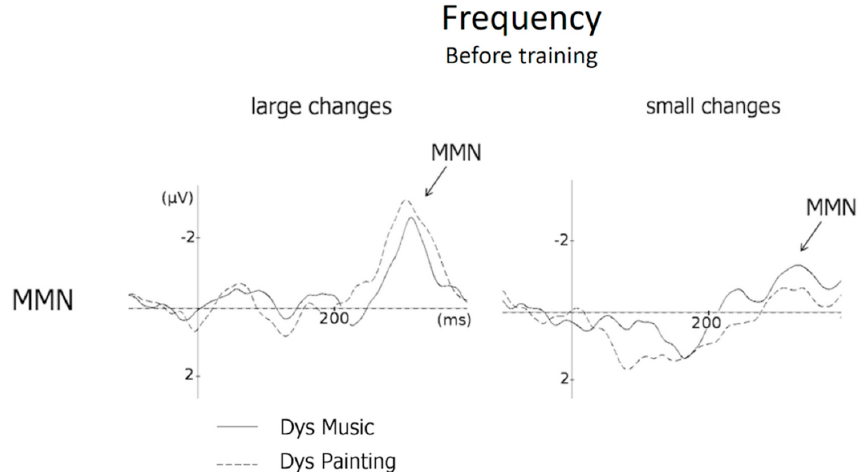
Figure 6. MMN at Fz to large and small frequency changes before training. MMNs are overlapped for children with dyslexia in the music group (solid line) and in the painting group (dashed line).